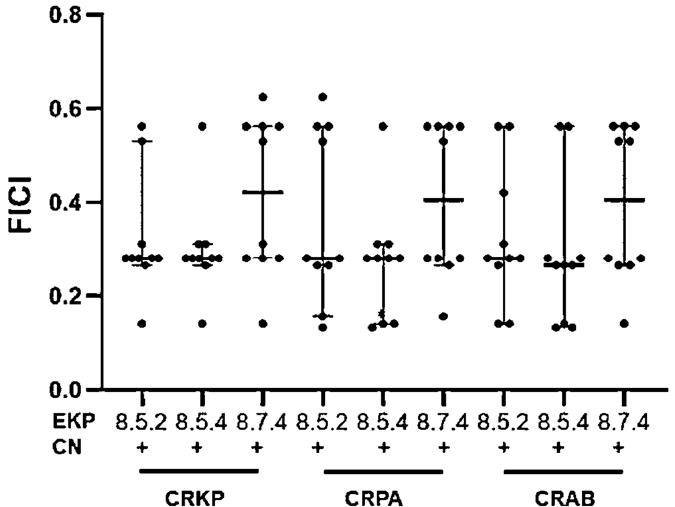
Figure 5. Scatter dot plot showing median values with 95%CI of FICI of the selected purified EKP extracts, EKP 8.5.2, EKP8.5.4, and EKP8.7.4 ( n = 10) combined with gentamicin (CN), which was separately tested with CRKP, CRPA, and CRAB. *, Significant difference apart from CN at p ≤ 0.05 as shown with a solid line. The results revealed that EKP 8.5.2, EKP 8.5.4, and EKP 8.7.4 purified extracts showed 80% and 20%, 90% and 10%, and 50% and 50% synergistic and partial synergistic effects to gentamicin against the tested CRKP ( n = 10), respectively (Tables 2–4). As well as CRPA, these three EKP purified extracts demonstrated 60% and 40%, 90% and 10%, and 60% and 40% synergistic and partial synergistic effects to gentamicin against the tested CRPA ( n = 10), respectively (Tables 5–7). The three EKP purified extracts exerted 80% and 20%, 80% and 20%, and 50% and 50% synergistic and partial synergistic effects on gentamicin against the tested CRAB ( n = 10), respectively (Tables 8–10). It should be noted that the highest and lowest synergistic effects were shown in the combination of gentamicin with EKP 8.5.4 or 3,5,7,3 (cid:48) ,4 (cid:48) -pentamethoxyflavone, and EKP 8.7.4 or 5,7,4 (cid:48) -trimethoxyflavone. Table 2. Combination effect of gentamicin and EKP 8.5.2 extract against CRKP. CRKP MIC ( µ g/mL) FIC of FICI of CRKP CN EKP 8.5.2